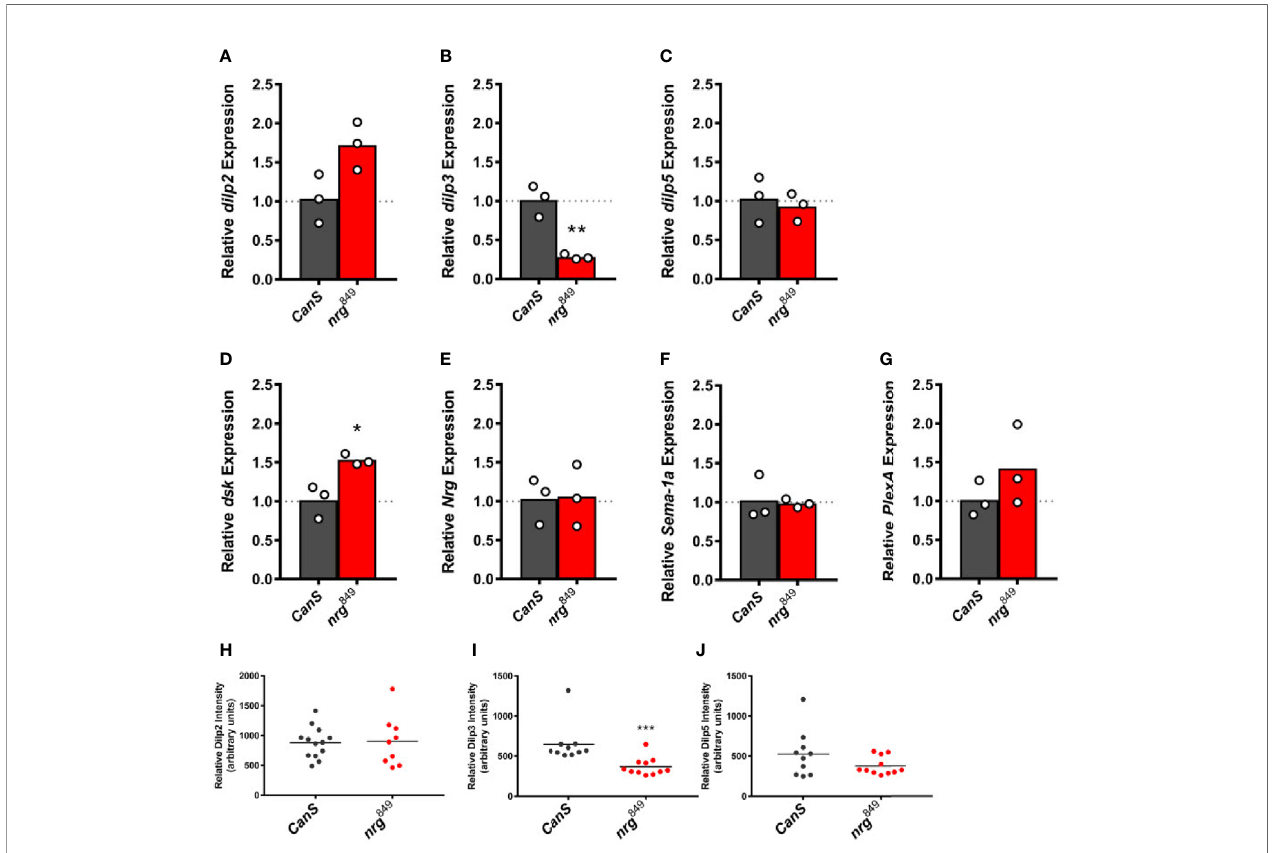
FIGURE 8 | Expression analysis of the IPC-expressed dilps, dsk, nrg, Sema-1a , and PlexA in nrg 849 adult female heads. At the transcript level, expression of dilp2 (A) is elevated 72% (unpaired t-test: P = 0.0530), dilp3 (B) is reduced to 28% of wildtype levels (**P = 0.0034), dilp5 (C) is unchanged, dsk (D) is elevated 53% (unpaired t-test: *P = 0.0159), and expression of nrg (E) , Sema-1a (F) , and PlexA (G) are unaffected. At the peptide level, revealed by immunohistochemistry, Dilp2 levels (H) are unchanged, Dilp3 peptide levels (I) are reduced by 43% (unpaired t-test: ***P = 0.0003), and Dilp5 levels (J) are